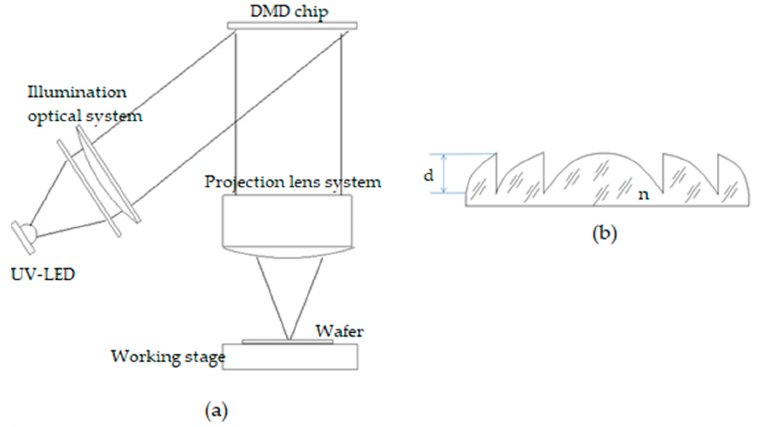
Figure 1. ( a ) Simplified structure of DMD-based lithography system. ( b ) Profile of a diffractive optical element (DOE). The DOE is formed by a ring-shaped diffraction grating which is rotationally symmetrical with respect to the optical axis. A structure of typical DOE is shown in Figure 1b. Oblique incidence is the normal working mode of DOE. In this paper, we assume the period widths of DOE are large enough or need not to be taken into account. According to scalar diffraction theory, the phase retardation at wavelength λ accounting for the incident angle θ can be expressed as in [28].